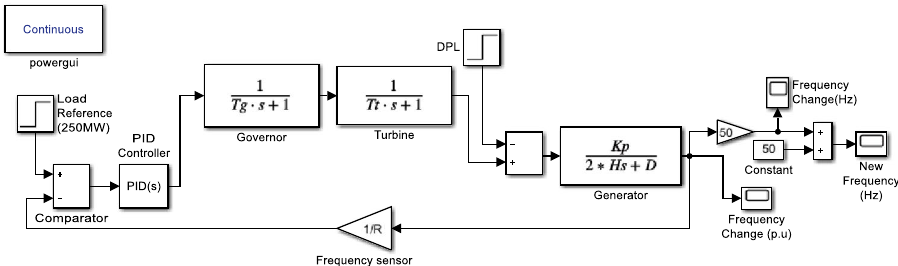
Fig. 2 Single area power generation existed PID control scheme in